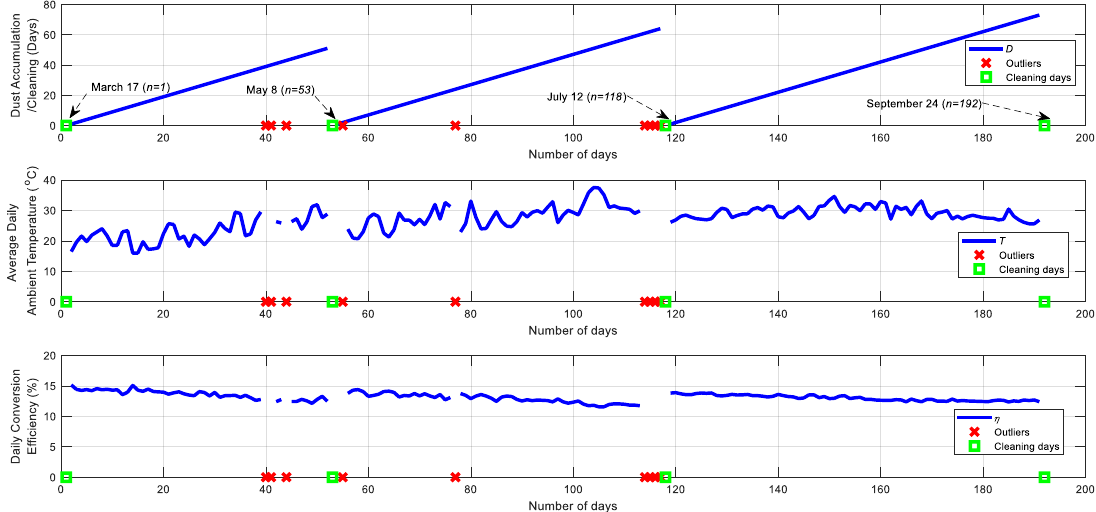
Figure 2. The dust accumulation (in terms of days of exposure) ( top ), the average daily ambient temperature ( middle ), and the daily system conversion efficiency ( bottom ), for the whole study period of n = 179 data points.